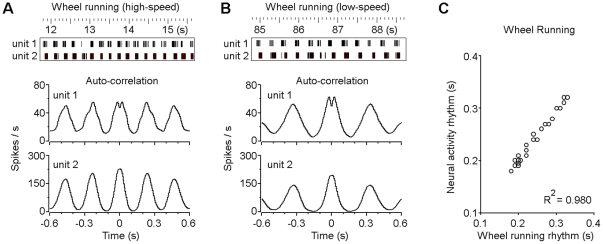
Activity of the VTA non-DA neuron correlates with the wheel running rhythm.(A and B) Rasters (upper panels) and smoothed auto-correlation histograms (lower panels) of two simultaneously recorded VTA non-DA neurons during high-speed (A) and low-speed (B) voluntary wheel running. (C) VTA neuron activity correlates with the limb-movement rhythm during wheel running.